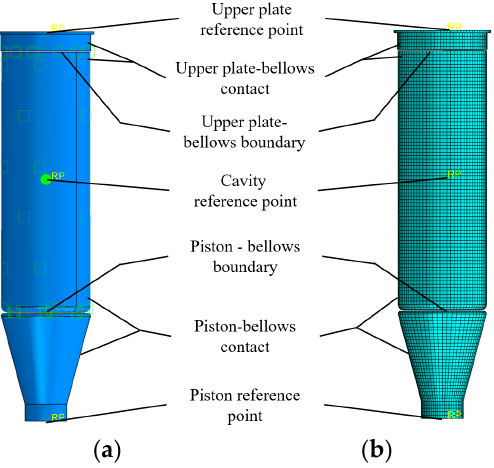
Figure 2. Boundary conditions( a ) and mesh generation ( b ) of finite element model.